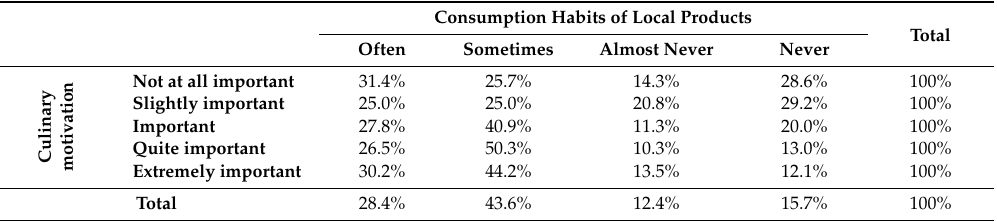
Table 7. Contingency between gastronomic motivation to travel and consumption habits of local